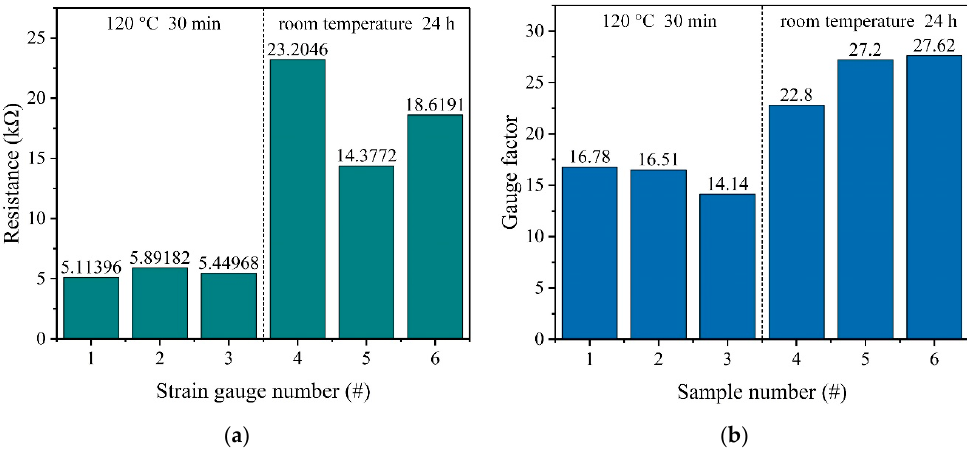
Table 2. Data for the resistance of the carbon paste-based strain gauges.